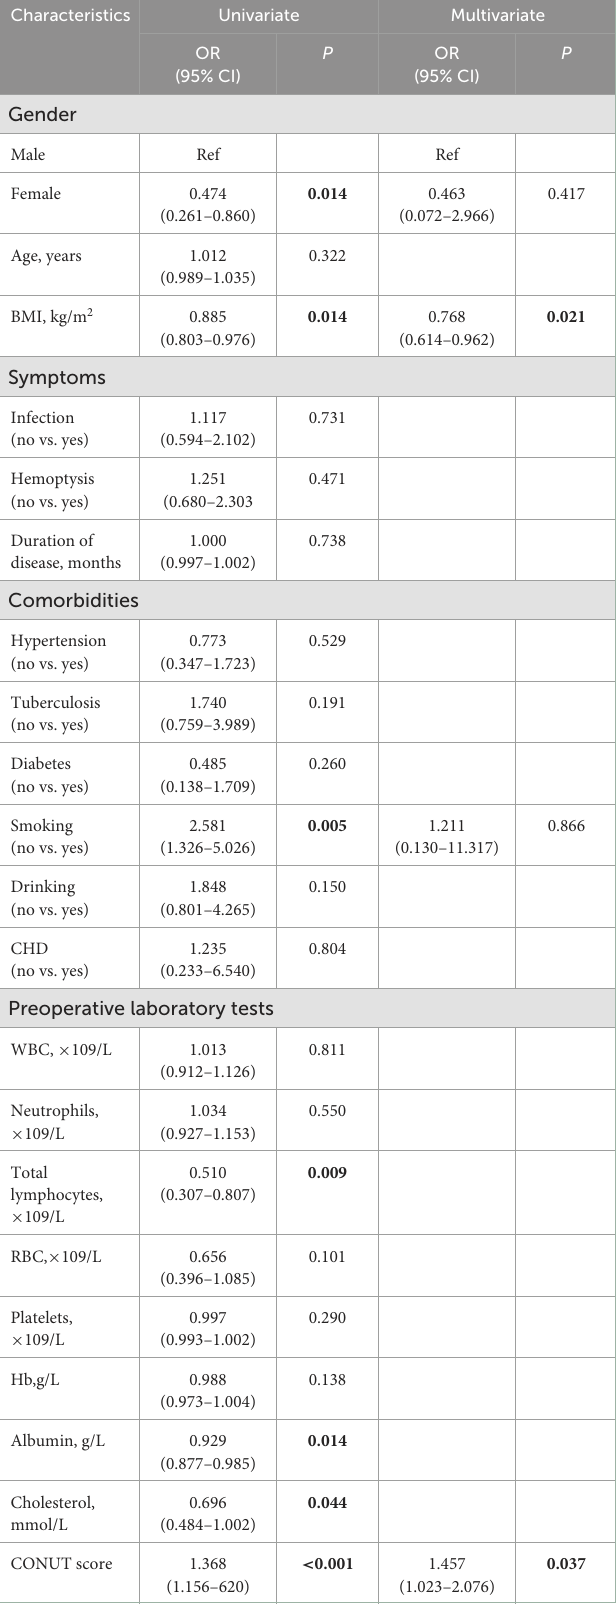
TABLE 4 Univariate and multivariate analyses of risk factors associated with postoperative